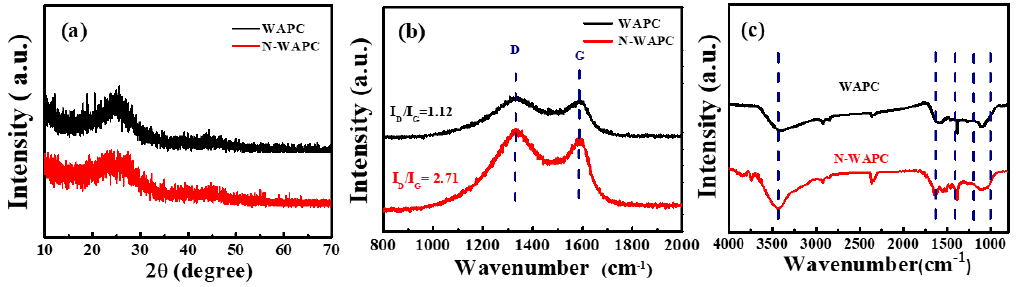
Figure 3. Powder XRD patterns ( a ), Raman spectra ( b ), and FT-IR spectra of WAPC and N-WAPC ( c ).